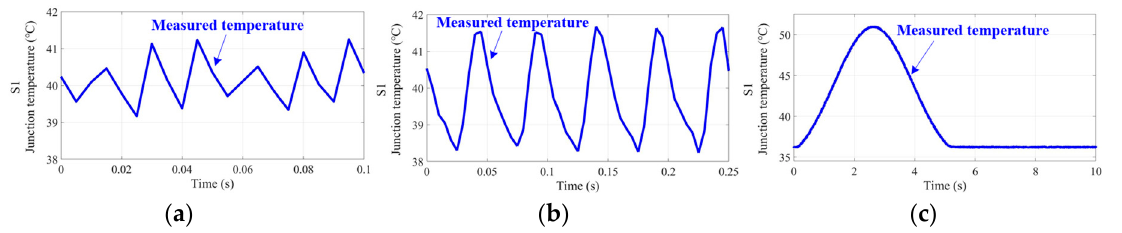
Figure 14. Measured temperature results of S 1 according to the fundamental frequency of the load current. ( a ) Frequency: 60 Hz; ( b ) Frequency: 20 Hz; ( c ) Frequency: 0.1 Hz